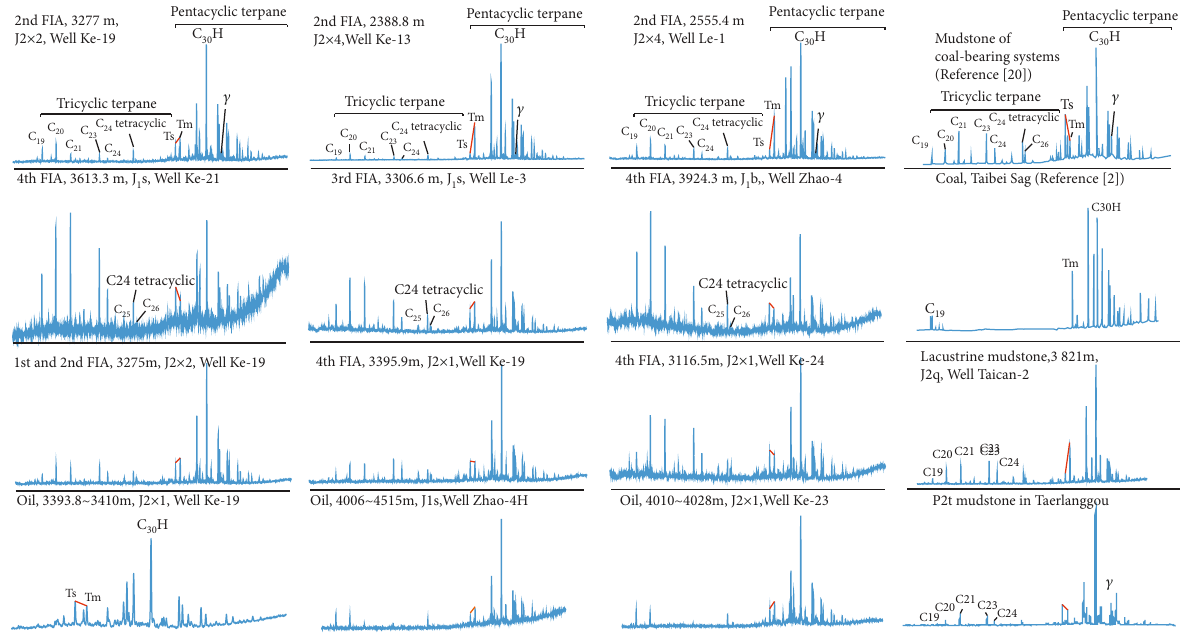
Figure 5: Terpene characteristics ( M / Z = 191 ) of the inclusions, crude oil, and the typical source rock in the northern piedmont belt, the Turpan-Hami Basin.